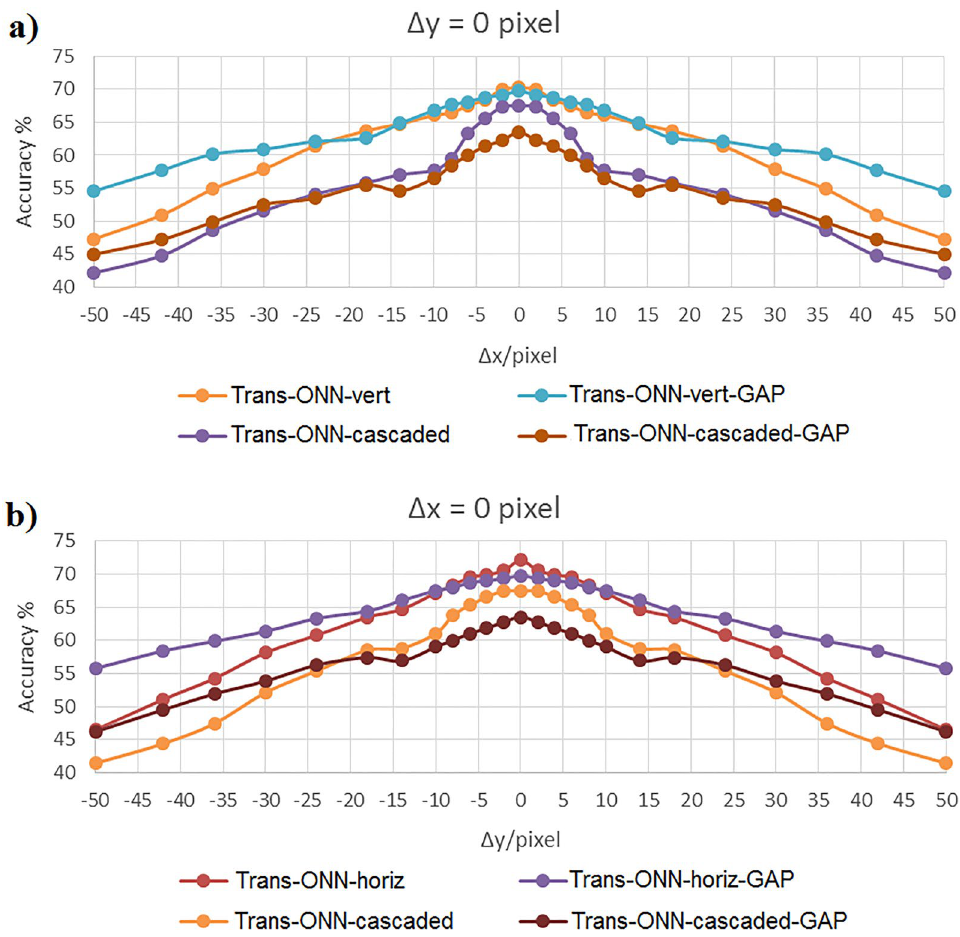
Figure 11. Classification accuracy of CIFAR-10 dataset by considering ( a ) vertical mask, and ( b ) horizontal